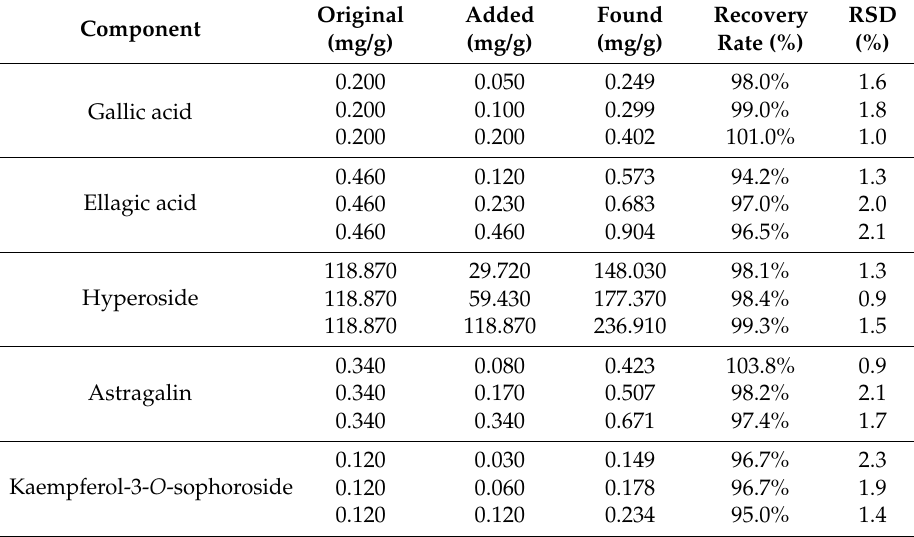
Table 1. Recovery rates of the five components in R. rugosa